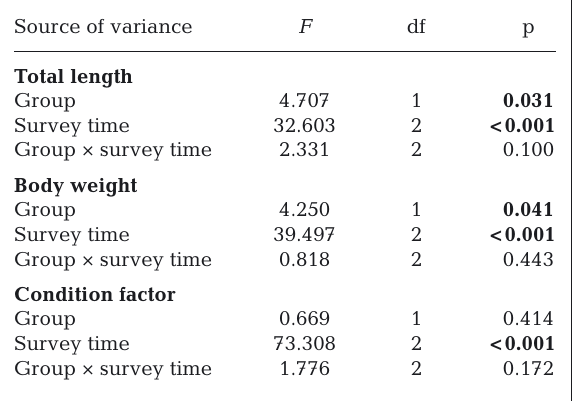
Table 1. Two-way ANOVA for comparison of differences in total length, body weight and condition factor between hatchery-reared mandarin fish and wild mandarin fish of the same age in 3 surveys 11, 16 and 19 mo after release. Bold type indicates significant differences (p < 0.05)